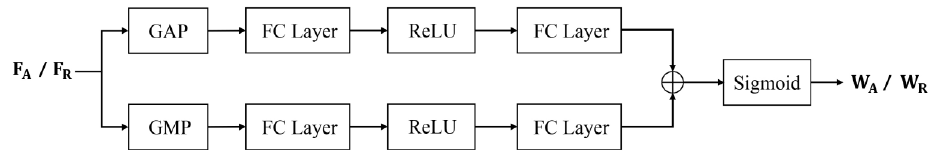
Figure 6. Structure of the FACAM and the